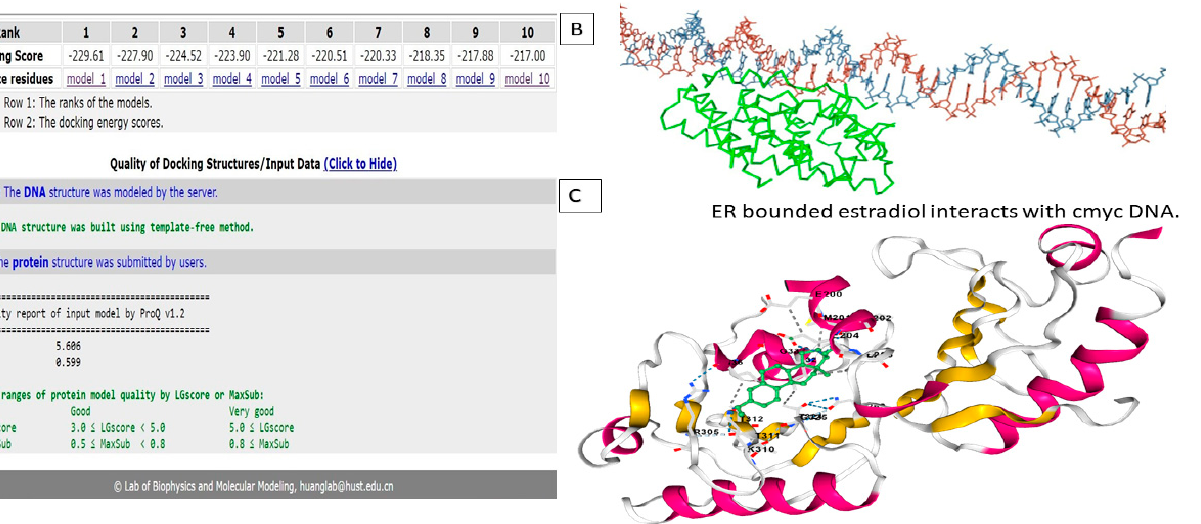
Figure 12. ( A ) Overall result of all models generated by HDOCK server ( B ) Binding of ER bound estra-